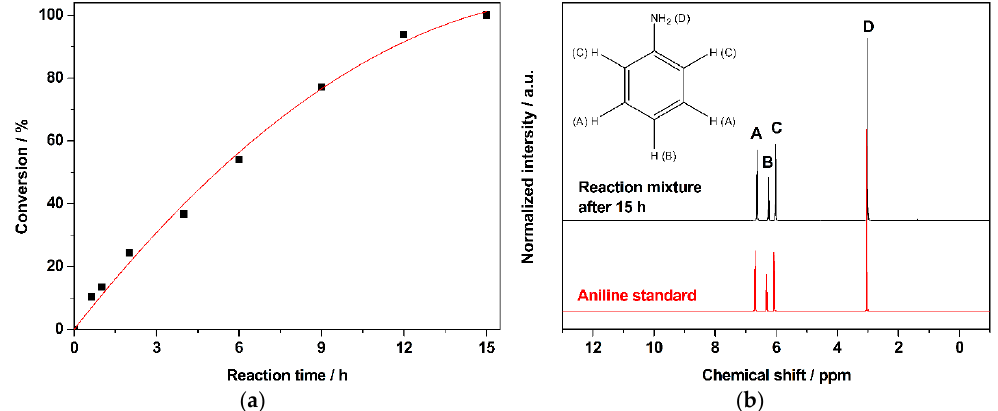
Figure 1. ( a ) Time-on-line plot for the solvent-free hydrogenation of nitrobenzene over 1% AuPd/TiO 2 (M Im ) catalyst. Reaction conditions: nitrobenzene: 78 mmol, catalyst: 100 mg, temperature: 90 °C, H 2 pressure: 3 bar. ( b ) Comparison of the 1 H-NMR spectra of the crude reaction mixture after 15 h without any purification and commercial aniline standard from Sigma Aldrich (>99.5% Purity).